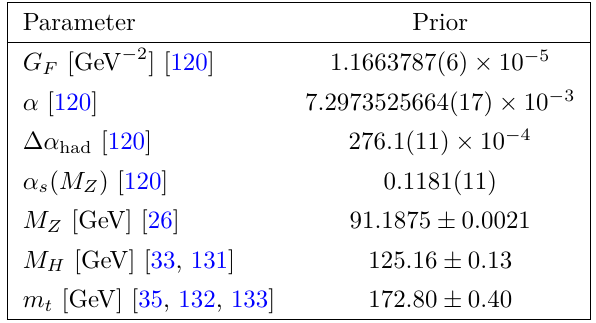
Table 4 . Parameters of the EW fit together with their (Gaussian)